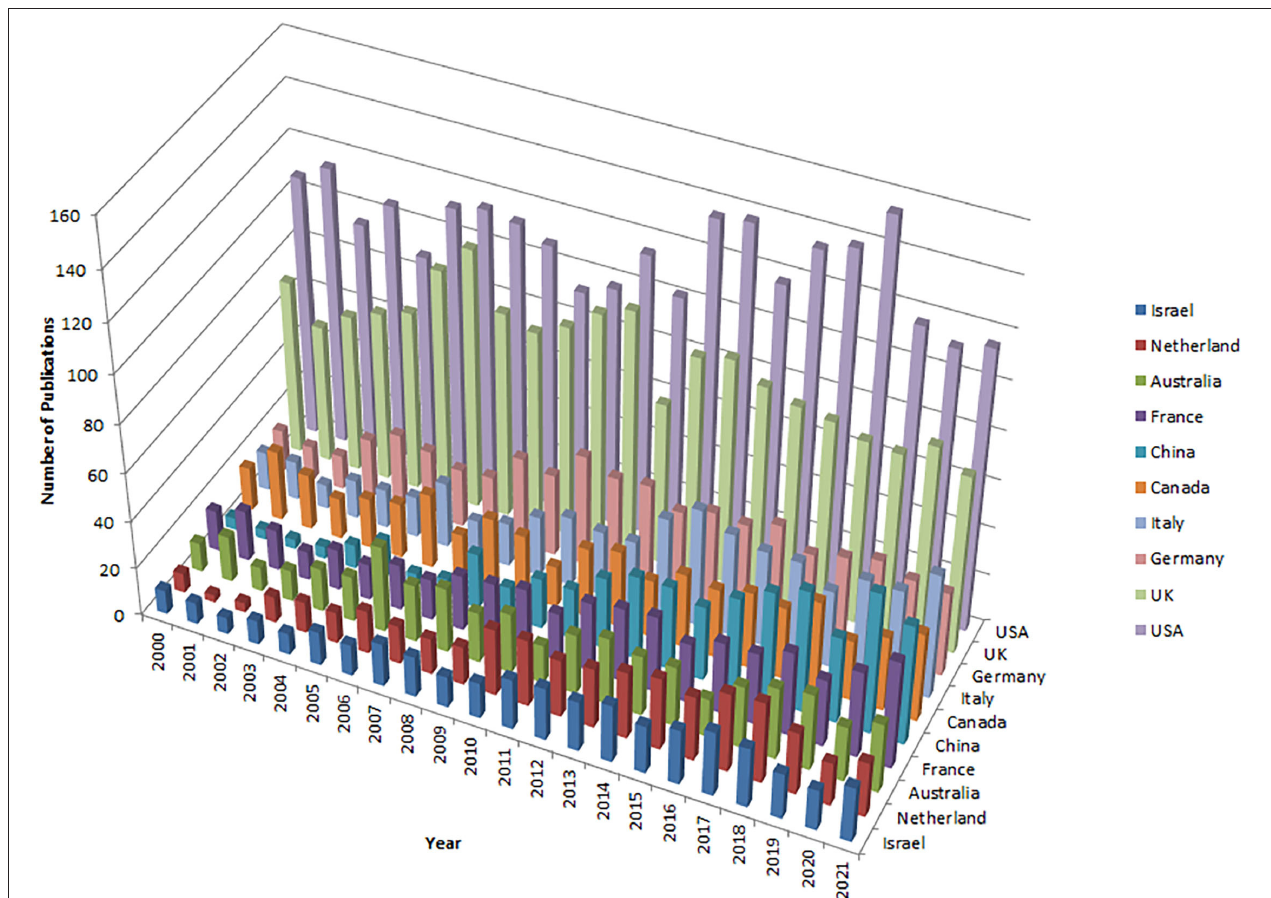
FIGURE 1 | The number of publications per countries by